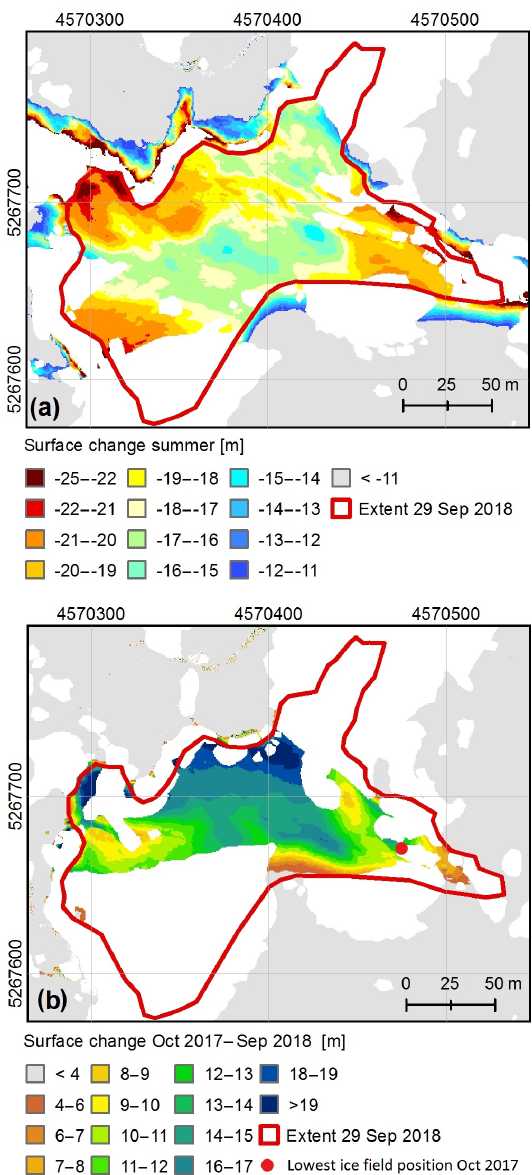
Figure 7. (a) Surface change during the ablation season 2018 (March–September) (b) and the surface change for the mass bal- ance year 2017/2018 (October 2017–September 2018). The red dot marks the position of the ice field snout in October 2017.